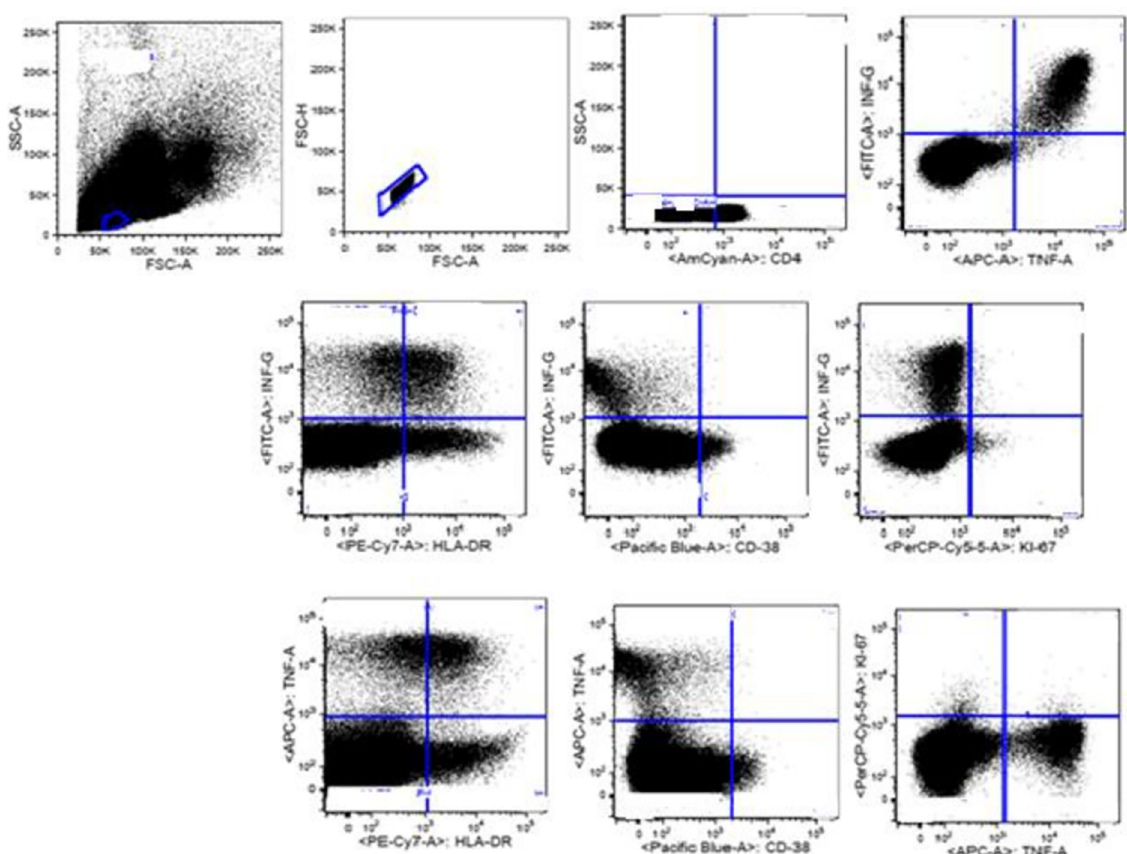
Fig 1. Flow cytometry gating strategy for the TB biomarkers study in selected health centers, Addis Ababa, Ethiopia from August 2020- July 2021.